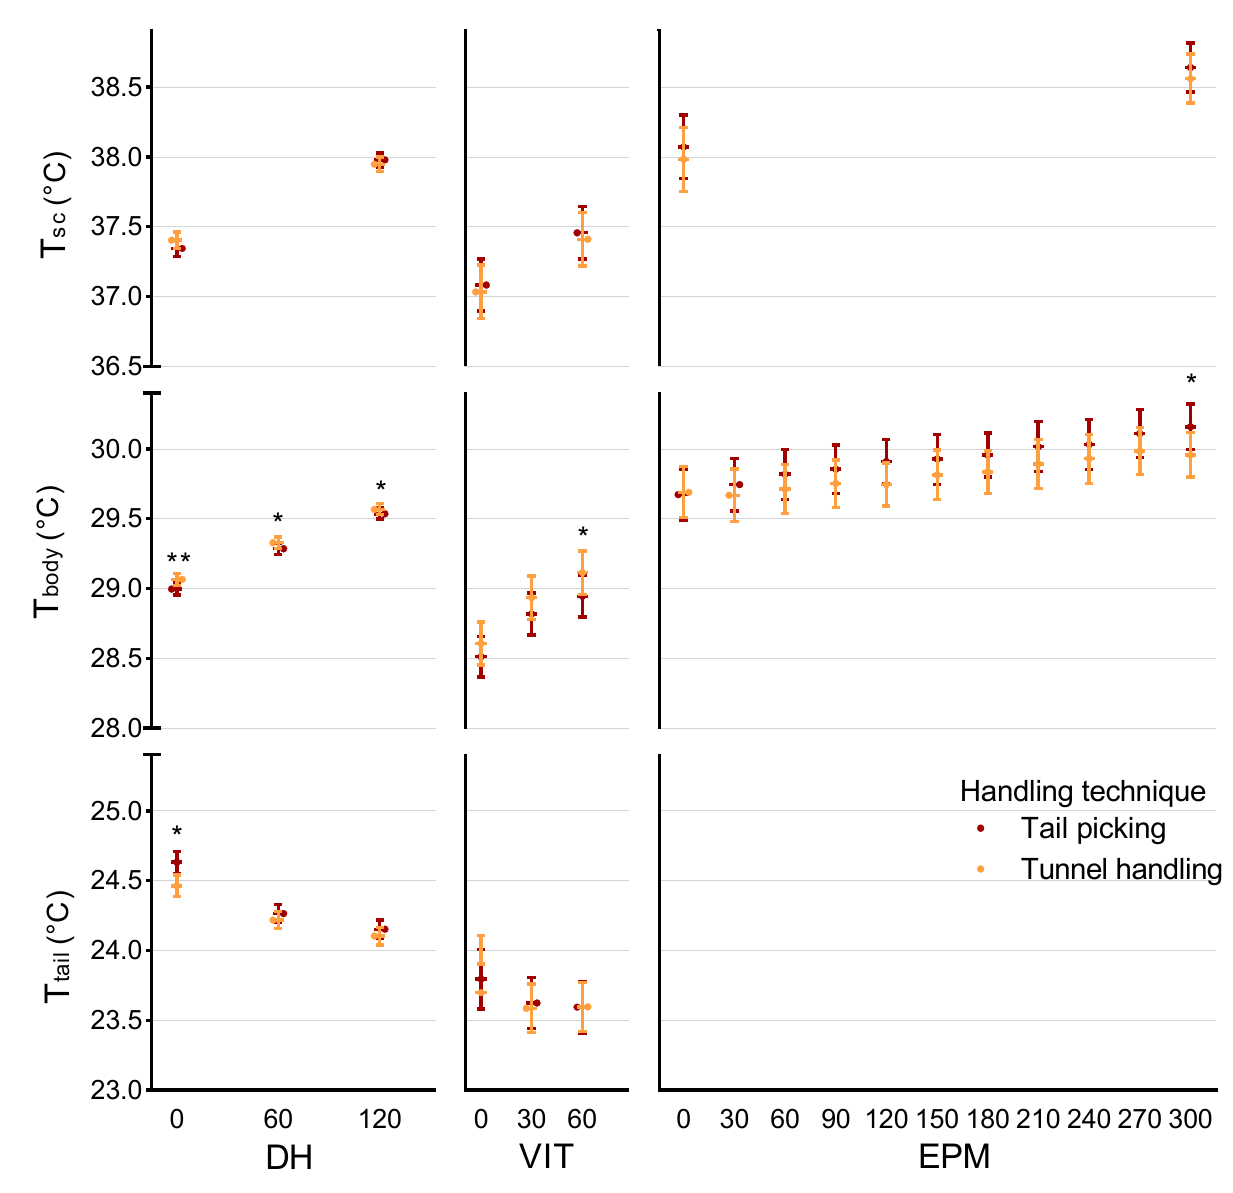
Figure 4. T sc , T body and T tail during Daily Handling (DH), Voluntary Interaction Test (VIT) and Elevated Plus Maze (EPM), at predefined time points, presented for effect of handling technique (orange—tunnel-handled, red—tail-picked). Errors bars represent 95% CI, * p < 0.05, ** p < 0.01. T tail dropped significantly during DH trials (F = 256.81, p < 0.001, Figure 3, DH-T tail )